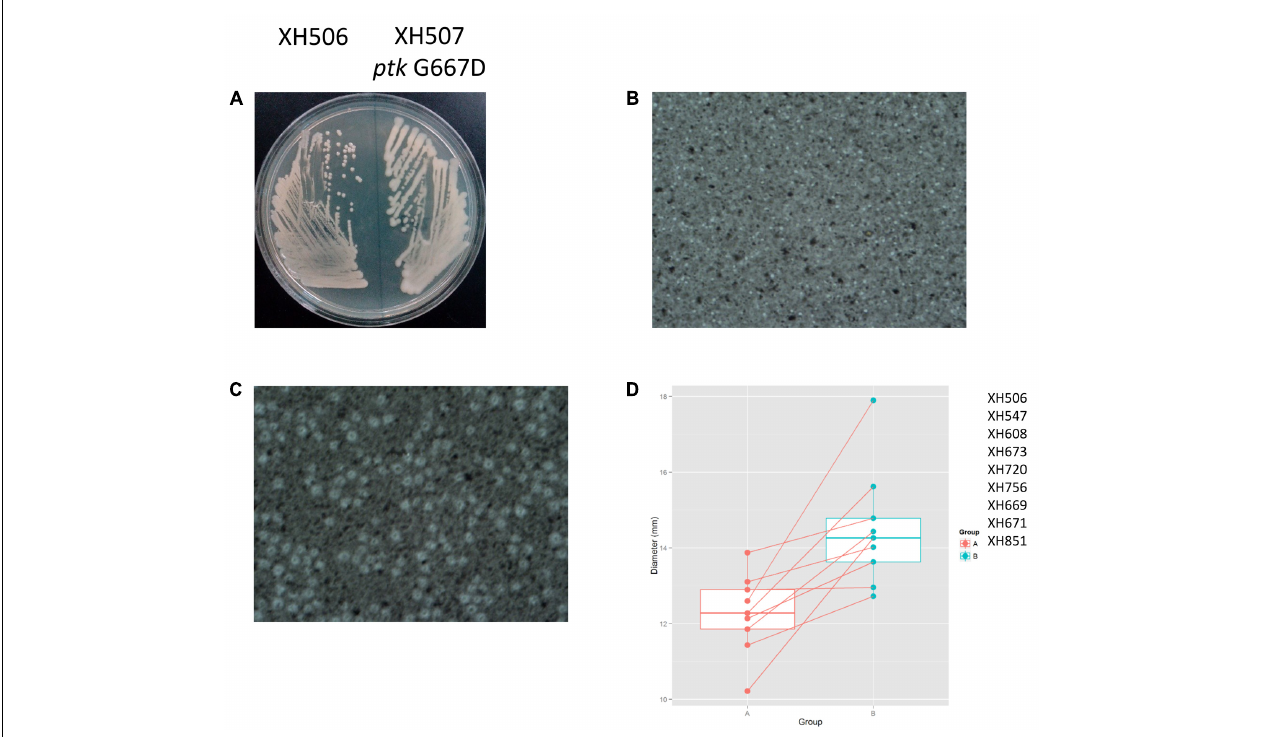
FIGURE 8 | Spontaneous point mutations in ptk resulted the misregulation of capsular exopolysaccharide production and higher motility. (A) Colony morphology on MH plates. (B,C) Capsules of XH506 and XH507 ( ptk G667D) were analyzed by India ink staining. (D) Spontaneous ptk mutants showed higher motility than the wild type. The y -axis indicates the measurement of diameter (mm) of the cell halos of each isolate pairs harbored ptk mutations in Group B. The data are represented as the means ± SD of experiments that were performed in